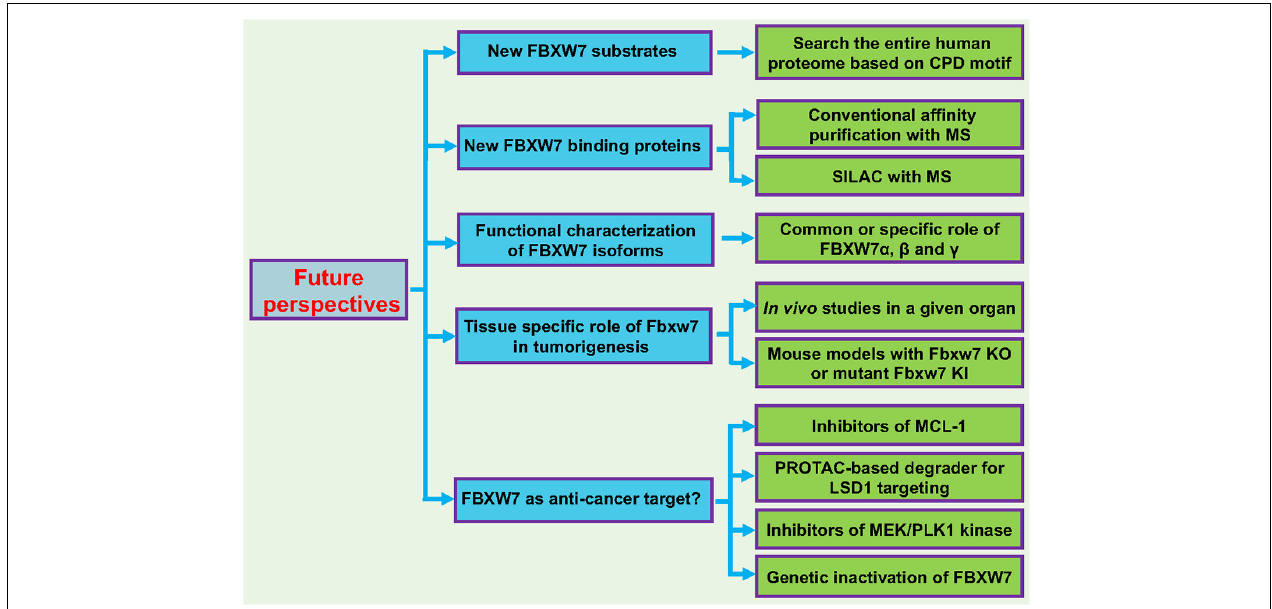
FIGURE 5 | Future perspectives. Five future directions are proposed to further broaden our understanding of FBXW7 functions: (1) Identification and characterization of new FBXW7 substrates; (2) Identification and characterization of FBXW7 binding proteins; (3) Functional characterization of FBXW7 isoforms ( α , β , and γ ); (4) Tissue specific role of Fbxw7 in tumorigenesis using mouse cKO or KI models; (5) Target human cancers by reactivating FBXW7. See text for